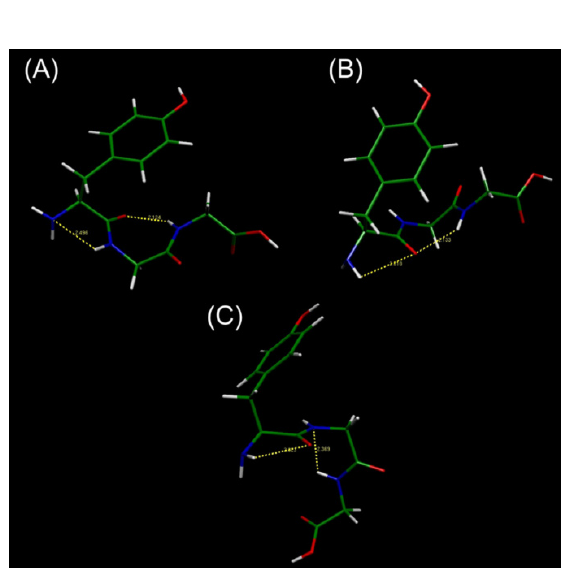
Figure 4. Stereoview of the three most populated families of YGG optimized at EDMC/SRFOPT/ECCEP/3 level of theory.